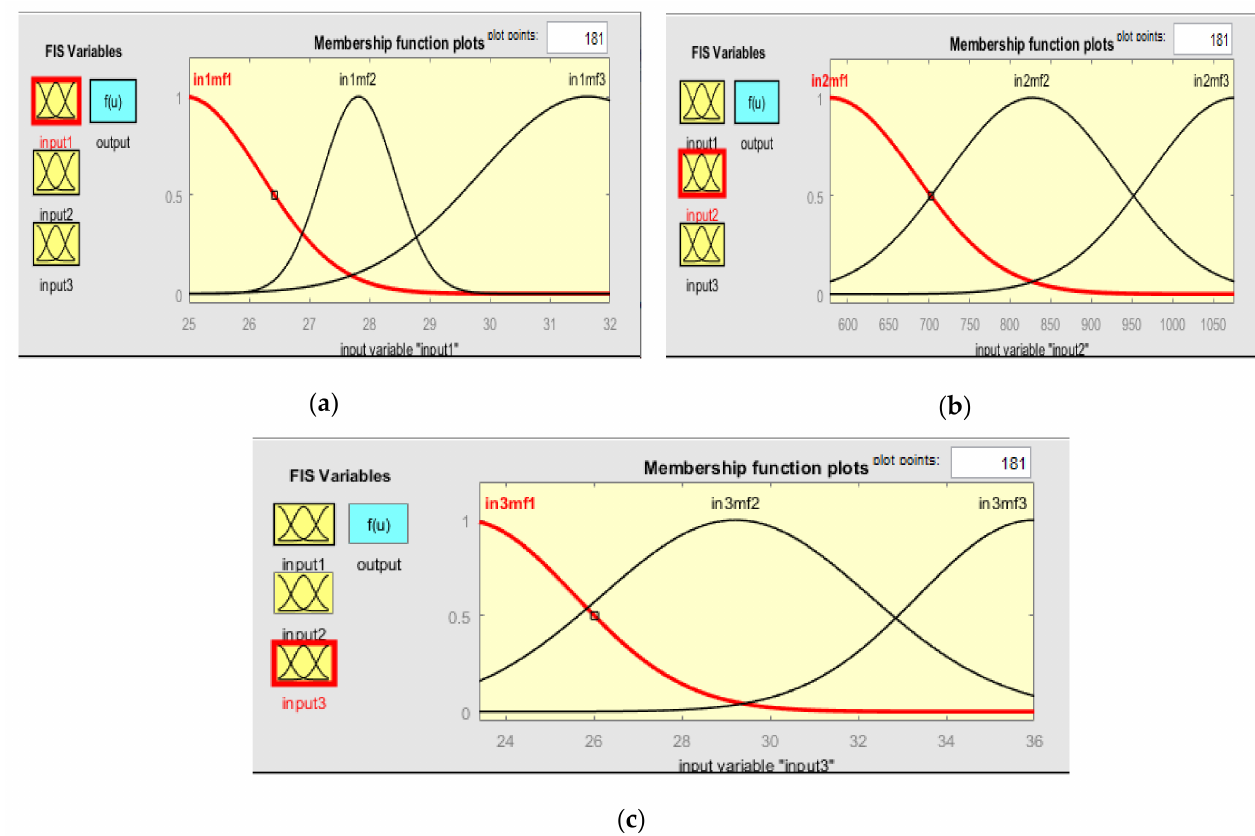
Figure 17. Membership function: ( a ) input 1: Ta; ( b ) input 2: Ec; ( c ) input 3: